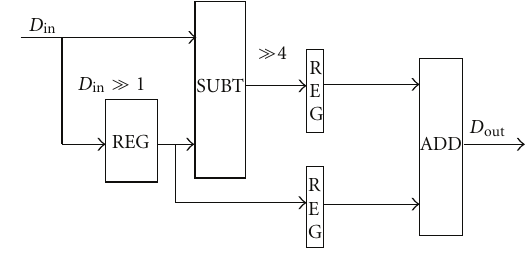
Figure 3: Block diagram of interpolator circuit.